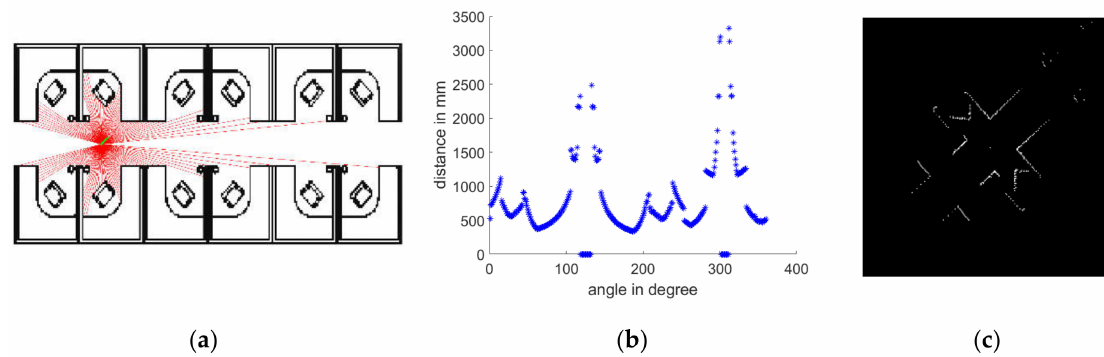
Figure 2. ( a ) Simulation of scan in environment, ( b ) raw scan data, and ( c ) scan image.